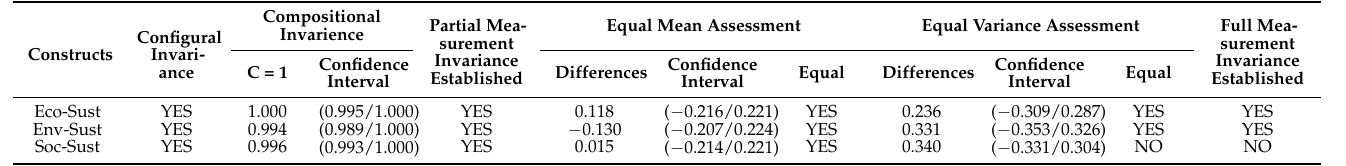
Table 6. Results of Invariance Measurement Testing Using Permutation (MICOM).